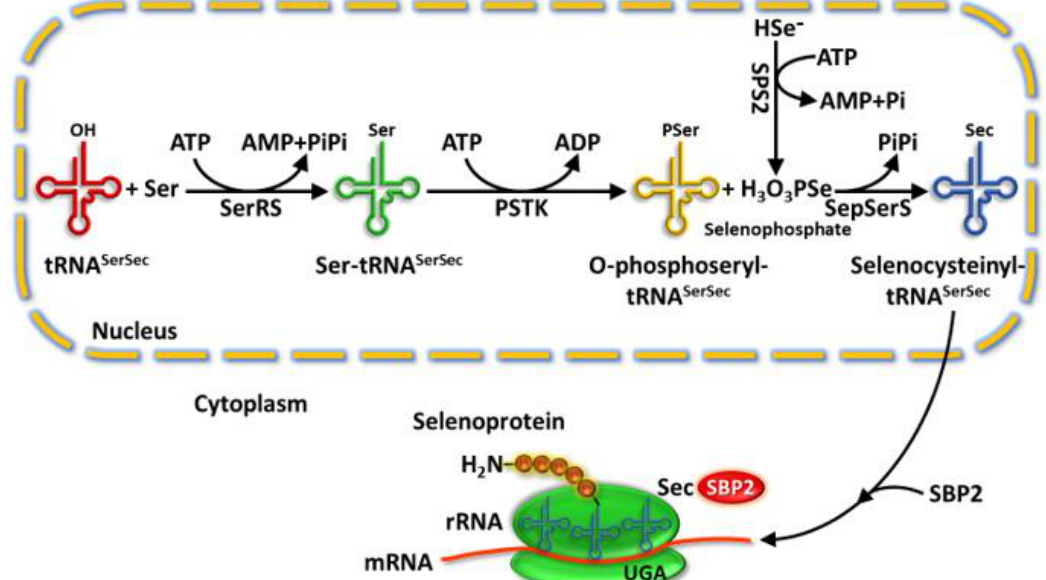
Figure 1. Selenoprotein biosynthesis pathway. SerRS catalyzes the reaction between tRNA SerSec and Ser in the presence of ATP to yield Ser-tRNA SerSec , which in turn is phosphorylated in the presence of ATP and PSTK to give O-phosphoseryl- tRNA SerSec . Thus, O-phosphoseryl- tRNA SerSec is replaced by Se in the presence of selenophosphate and SepSerS to synthesize Sec-tRNA SerSec . Sec-tRNA SerSec is transferred to the ribosome thanks to SECIS and SBP2. Finally, the UGA codon is recognized as the Sec integration codon into the amino acid sequence of selenoprotein. Abbreviations: SeC = Selenocysteine; SerRS = Seryl-tRNA synthetase; mRNA = messenger RNA; rRNA = ribosomal RNA; PSTK = O-phosphoseryl tRNA kinase; SPS2 = selenophosphate synthetase 2; SepSerS = O-phosphoseryl tRNA: selenocysteinyl tRNA synthase; SECIS = SeC Insertion Sequence; SBP2 = SECIS Binding Protein 2.